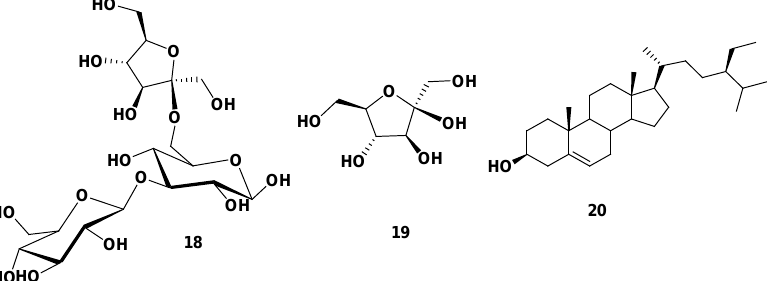
Figure 3. Structures of isolated compounds from coconut seed extract.